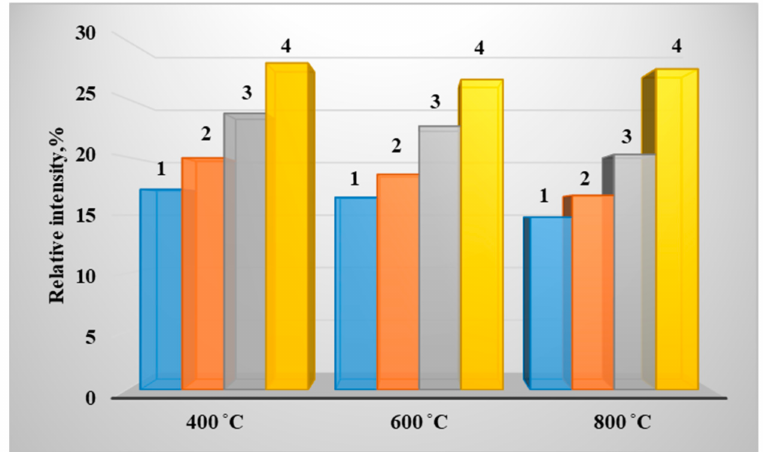
Figure 5. Change in the content of calcium sulfate in ash of 3B coal, wood and a mixture of coal with wood (with an increase in the mass of wood in the mixture) during pyrolysis in an inert medium of fuel samples weighing up to 15 g in the temperature range from 400 ◦ C to 800 ◦ C: 1. Coal 3B_100%; 2. Coal 3B_90%/Wood_10%; 3. Coal 3B_75%/Wood_25%; 4. Coal 3B_50%/Wood_50% [36].